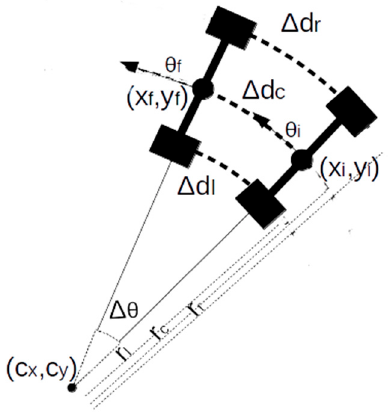
Figure 2. Odometric model.